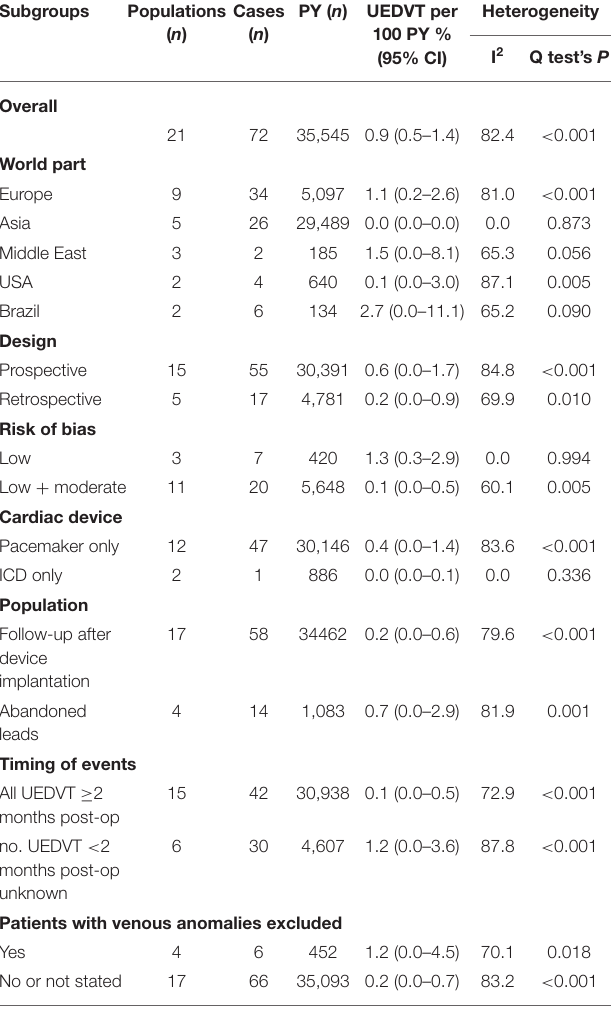
TABLE 1 | Subgroup analysis for the incidence of symptomatic